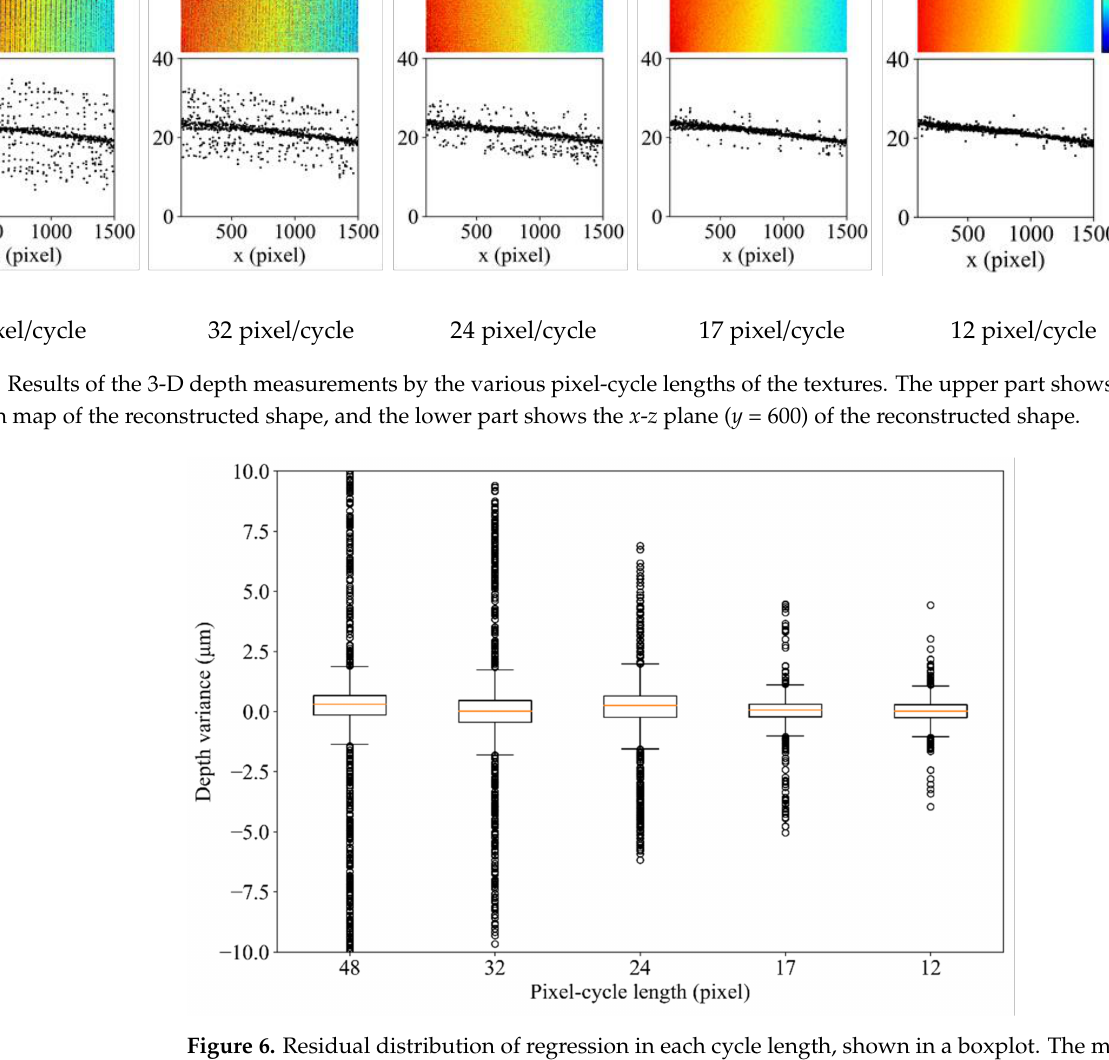
Figure 6. Residual distribution of regression in each cycle length, shown in a boxplot. The median is depicted by the orange line inside each box, and the interquartile range (IQR) is depicted by the length of the box. The whiskers correspond to 1.5 IQRs. The circles indicate